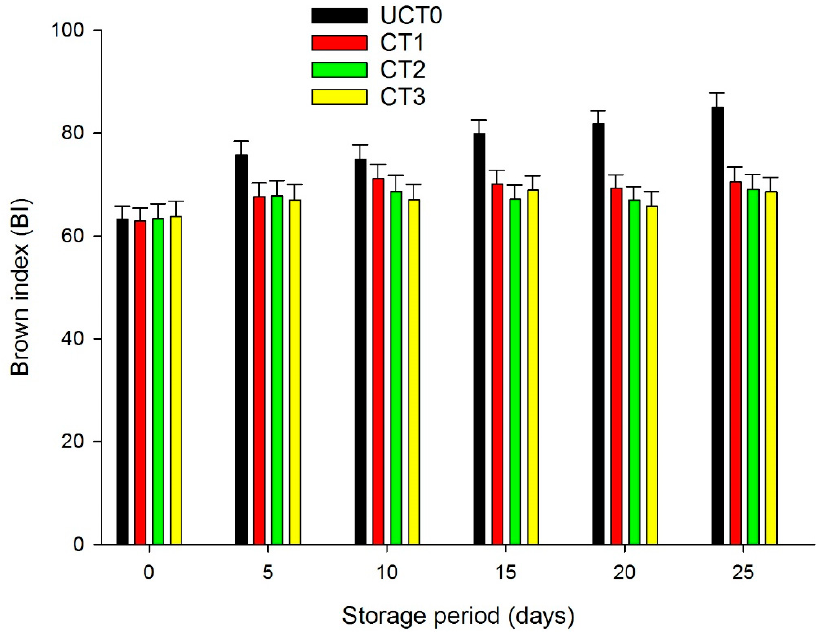
Figure 3. The brown index (BI) of Golden Delicious apple slices coated (with CT1, CT2, and CT3), and not treated (UCT0) at day 0, and after 5, 10, 15, 20, and 25-days of storage at 4 °C in dark conditions and 85% relative humidity (RH). Values indicate the means ± standard deviations ( n = 3). Abbreviations: UCT0, uncoated apple slices used as control; CT1, apple slices coated with chitosan-glycerol-cinnamon oil; CT2, apple slices coated with guar gum-glycerol-cinnamon oil; CT3, apple slices coated with composite guar gum-starch-glycerol-cinnamon oil.